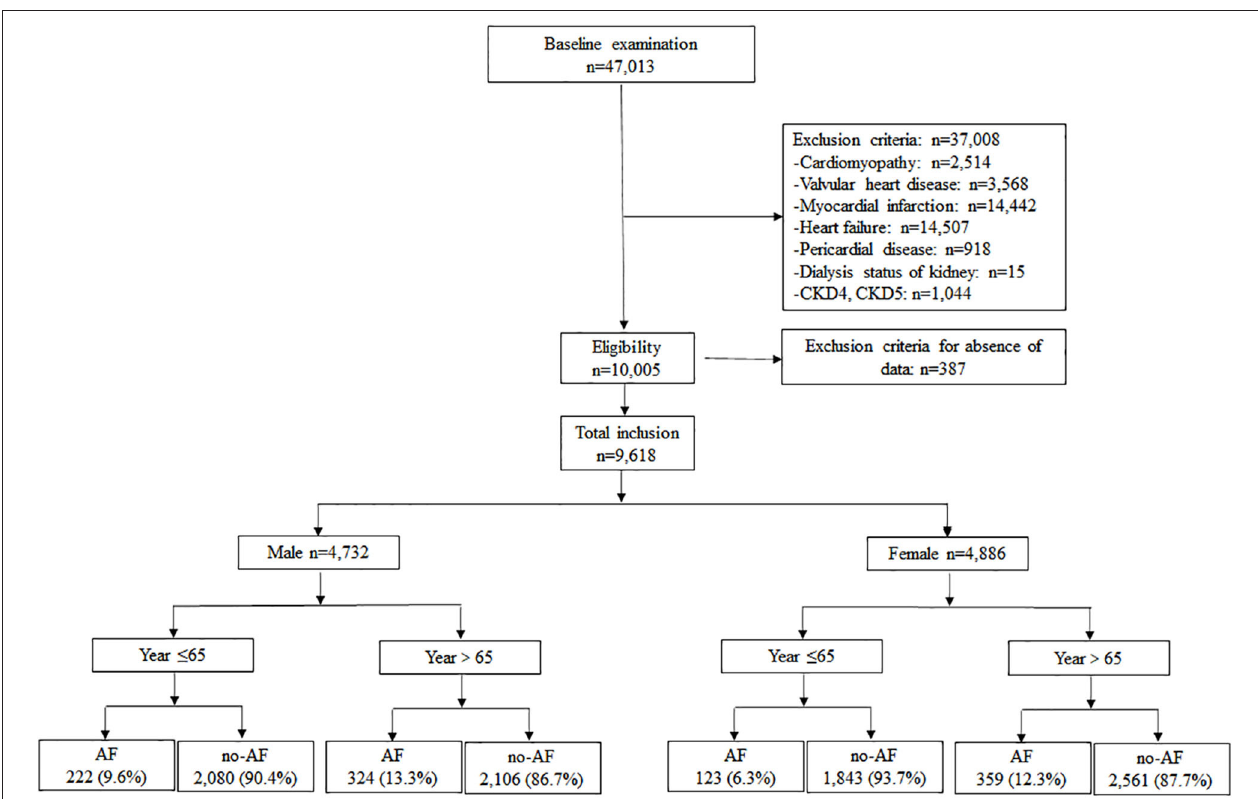
FIGURE 1 | The overview of the selection of study participants.